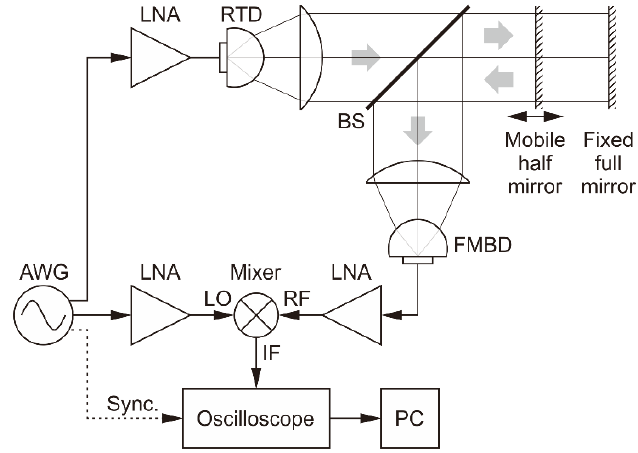
Figure 5. Schematic of the experimental setup configured in reflection. The beam splitter (BS) allows a normal incidence on the target, which in this case consists of a half mirror and a full mirror.